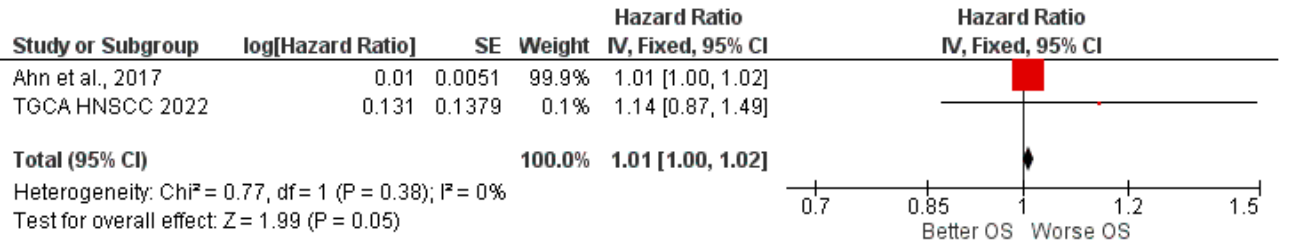
Table 4. Evaluation of GRADEpro GDT; CI, confidence interval; HR, hazard ratio, ⨁⨁◯◯ Low. Certainty Assessment